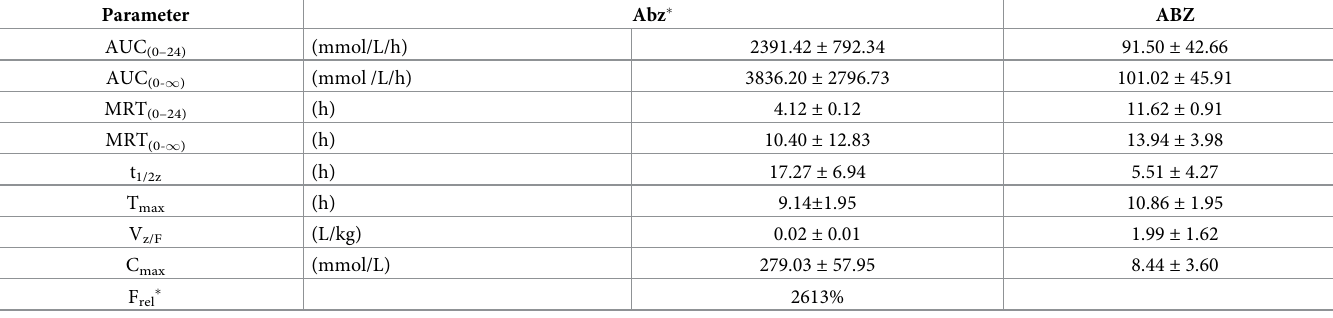
Table 2. Pharmacokinetic parameters of ABZ-BA and ABZ in SD rats (n = 7).